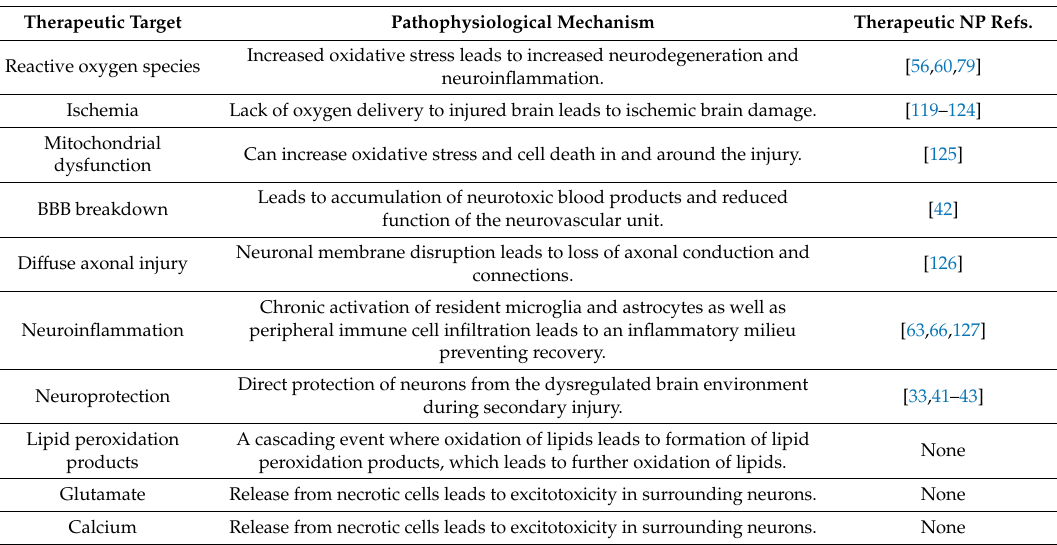
Table 2. Therapeutic targets where NP-mediated delivery could provide an advantage including references where NPs against these targets have been tested in preclinical animal